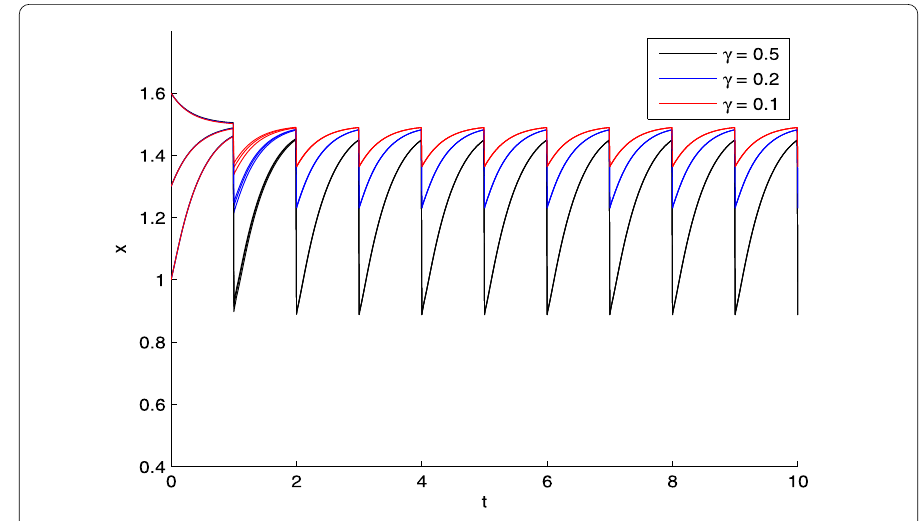
Figure 6 Dynamic behaviors of the species x ( t ) in system (1.4) with the initial conditions x (0) = 1, x (0) = 1.3, x (0) = 1.6, respectively